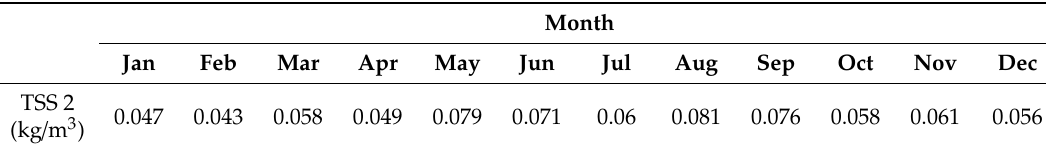
Table 4. Monthly amount of TSS 2 in 2015.